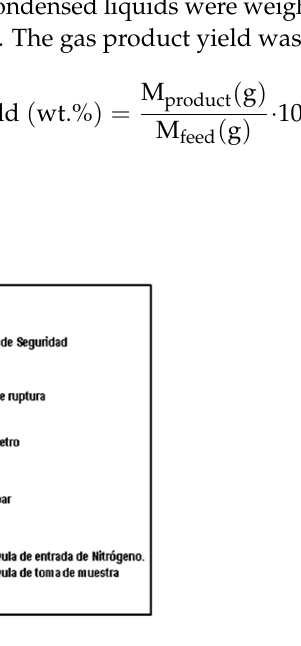
Figure 1. Pyrolysis